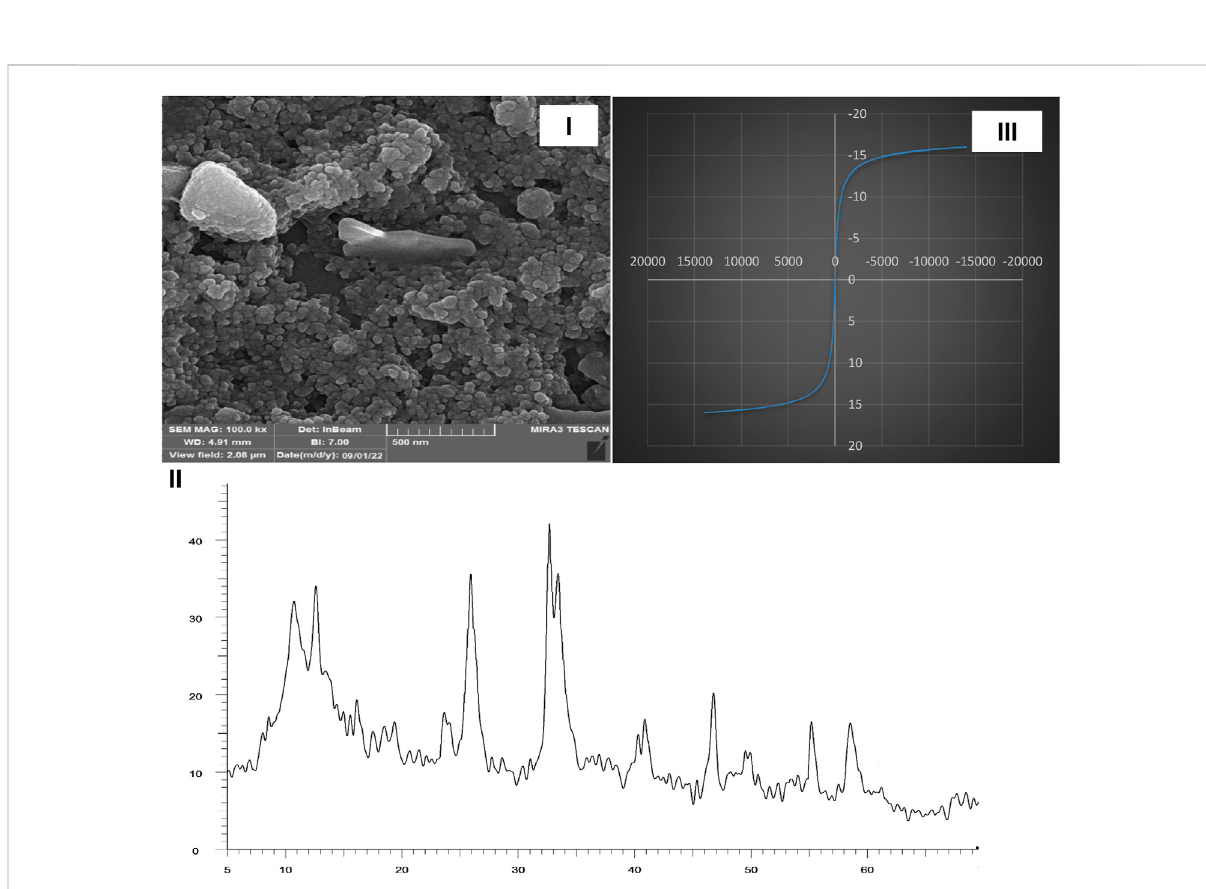
FIGURE 10 SEM (I), XRD (II), and VSM (III) of Fe 3 O 4 /Zn-metal organic framework magnetic nanostructures reusability in the synthesis of compound 4a.